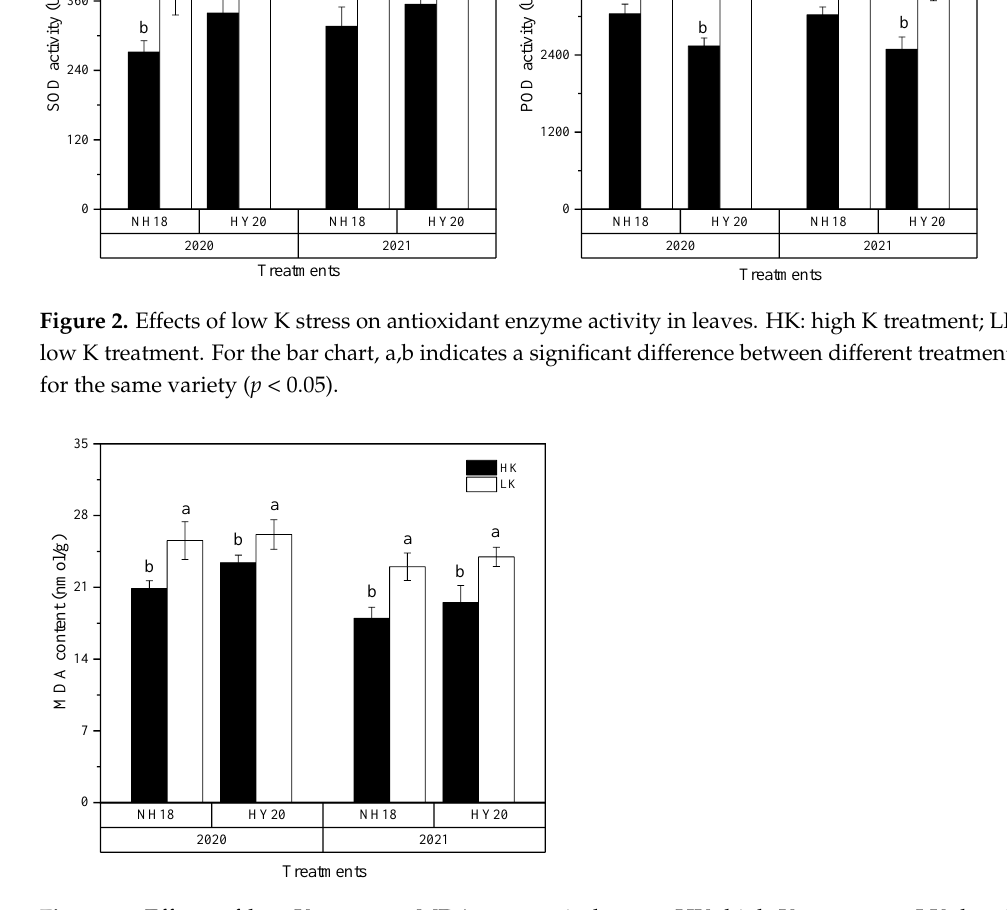
Figure 3. Effects of low K stress on MDA content in leaves. HK: high K treatment; LK: low K treatment. For the bar chart, a,b indicates a significant difference between different treatments for the same variety( p < 0.05).